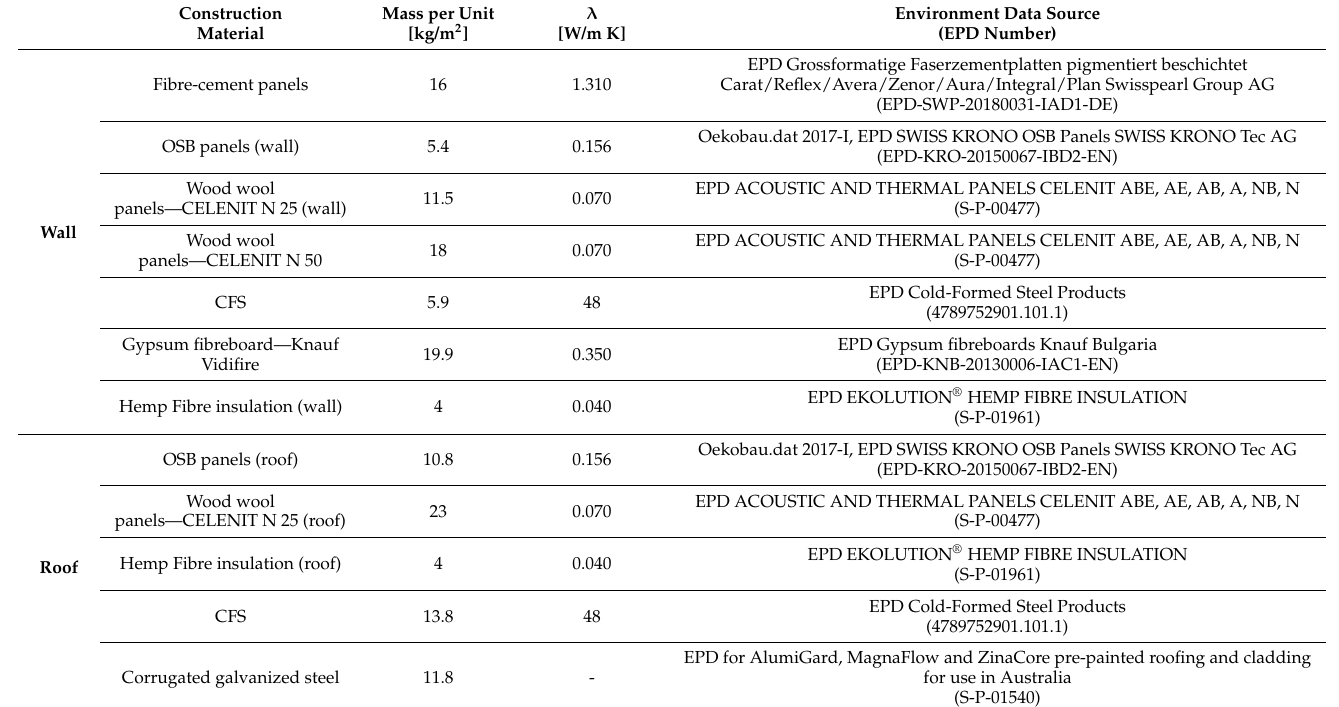
Table 8. Bill of material, thermal conductivity and data source: CFS configurations for 1 m 2 of wall and roof.